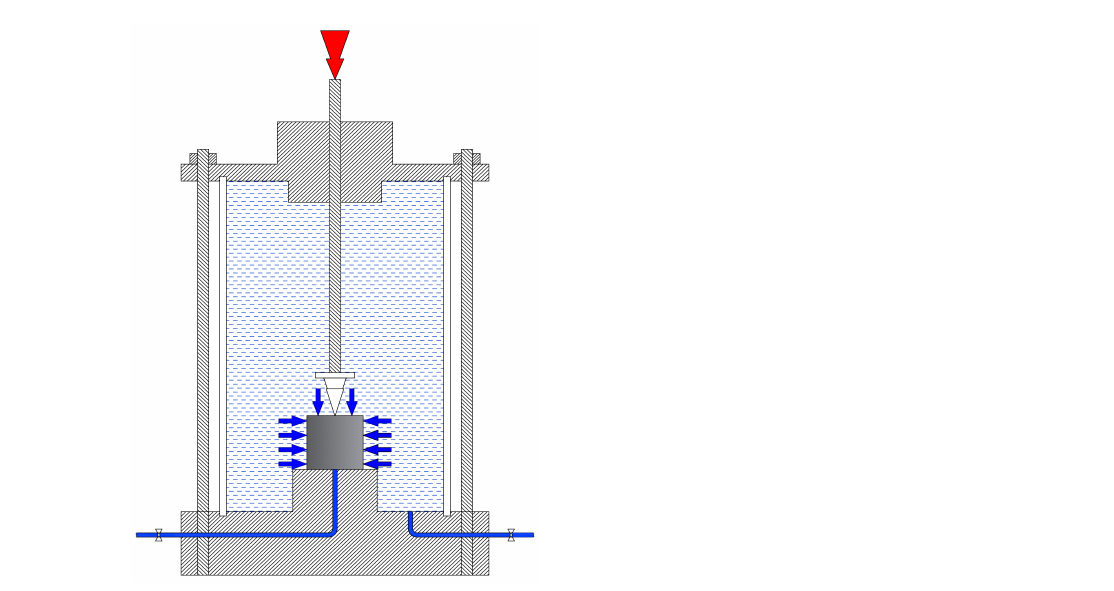
Figure 12. The modification of triaxial test equipment for underwater coal mining cutting re- sistance testing